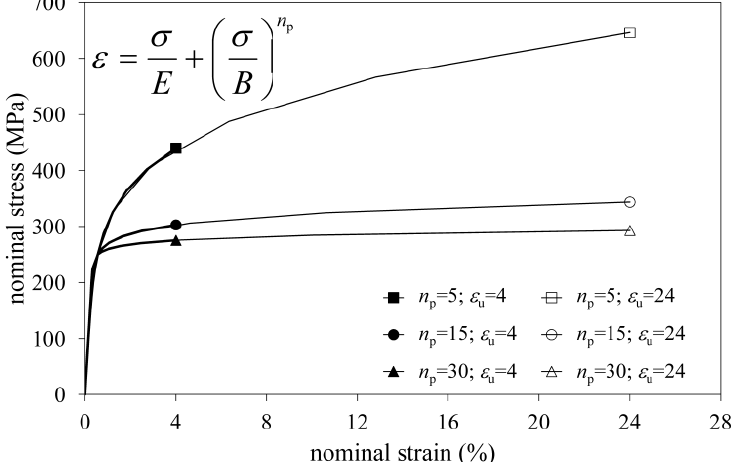
Figure 4. Nominal stress-strain curves for the six constitutive laws assumed in the parametric